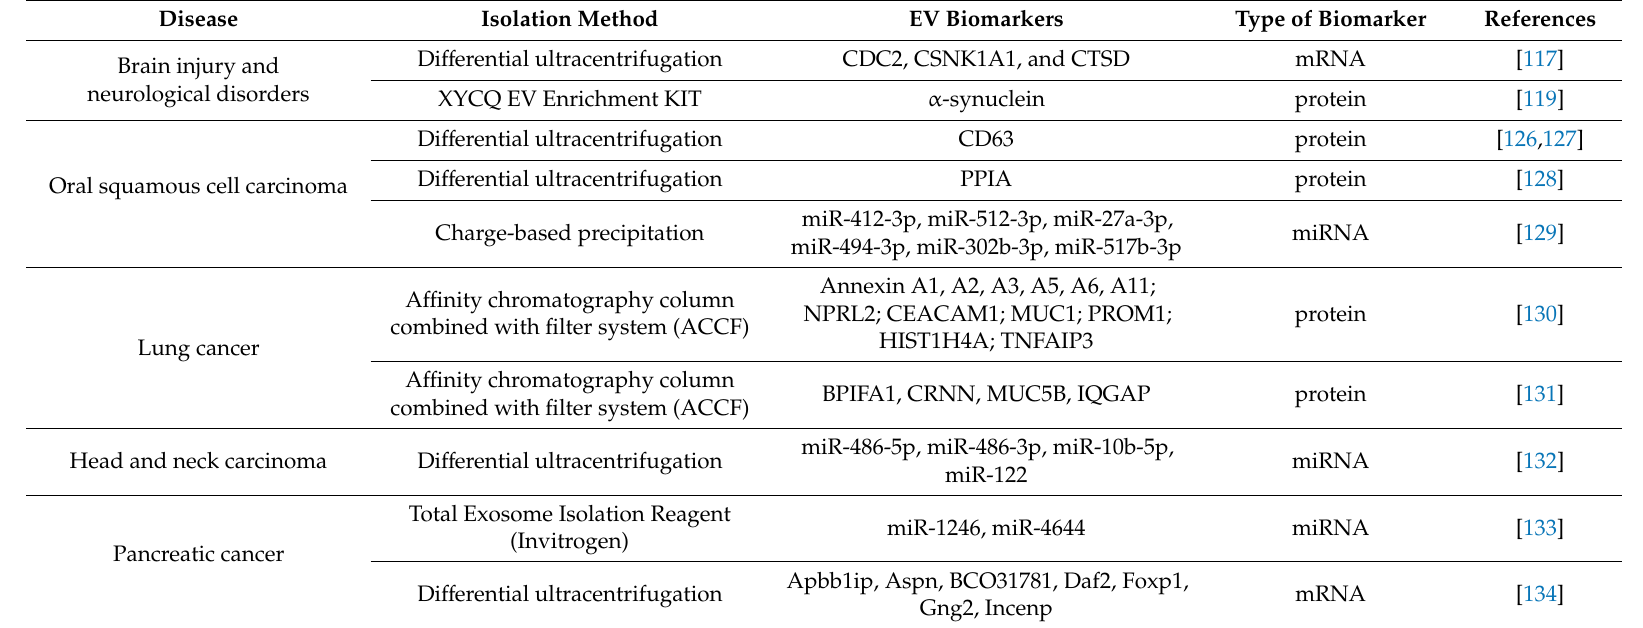
Table 3. Biomarkers detected in salivary EVs. Salivary EVs can be purified using di ff erent EV isolation techniques and can be exploited as biomarkers because they contain disease-related proteins and